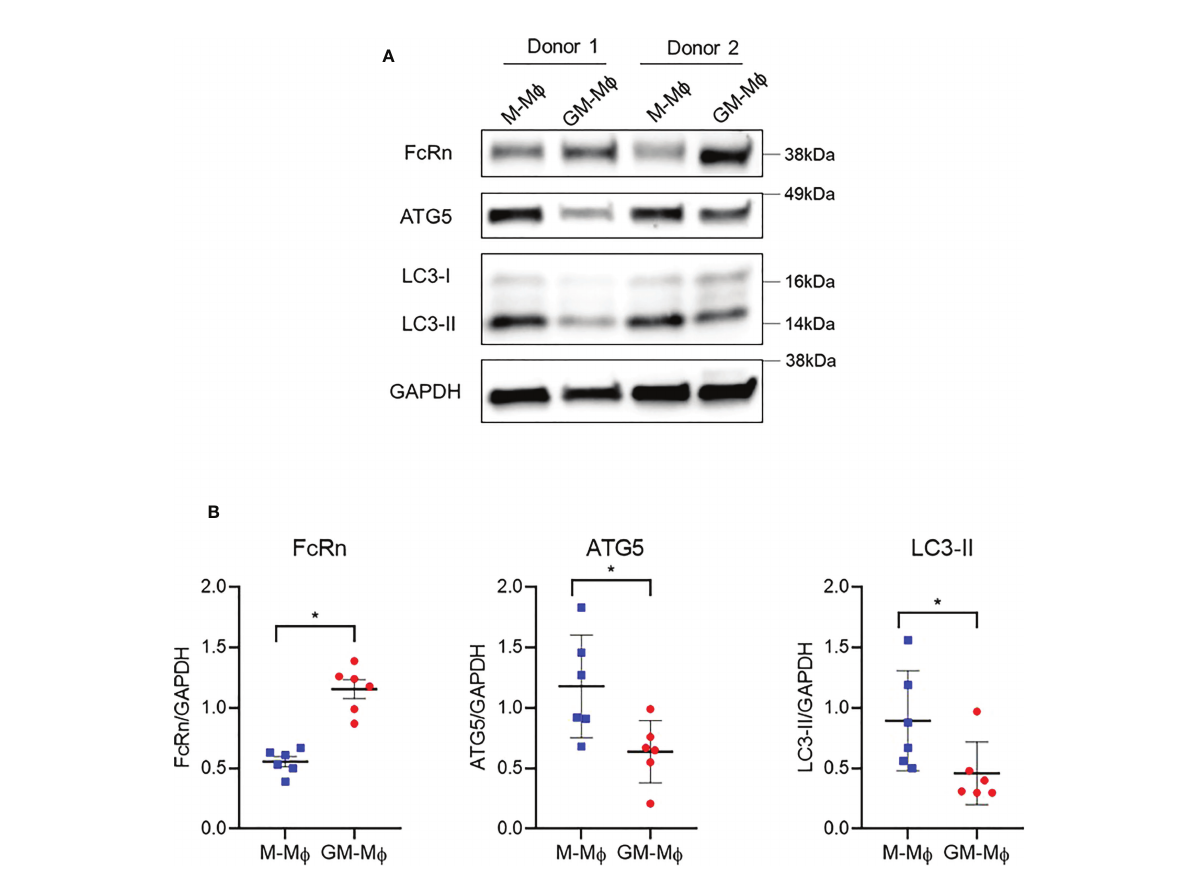
FIGURE 4 Western blot analysis of protein levels of ATG5, ATG7 and LC3-I/II involved in autophagy and FcRn expression in macrophages. Human monocytes were cultured with 60 ng/ml M-CSF or GM-CSF for 6 days. (A) Proteins were extracted from M-M f and GM-M f on day 6. One representative blot is presented. (B) Quanti fi cation of FcRn, ATG5 and LC3-I/II expression normalized to GAPDH expression (mean ± SD, N=6). M-M f , M-CSF – induced macrophages; GM-M f , GM-CSF – induced macrophages. *p ≤